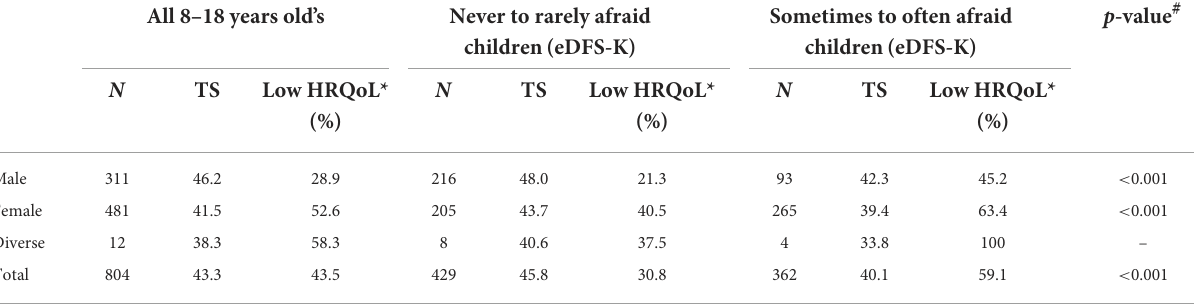
TABLE 3 Results of the self-reported KIDSCREEN-10.